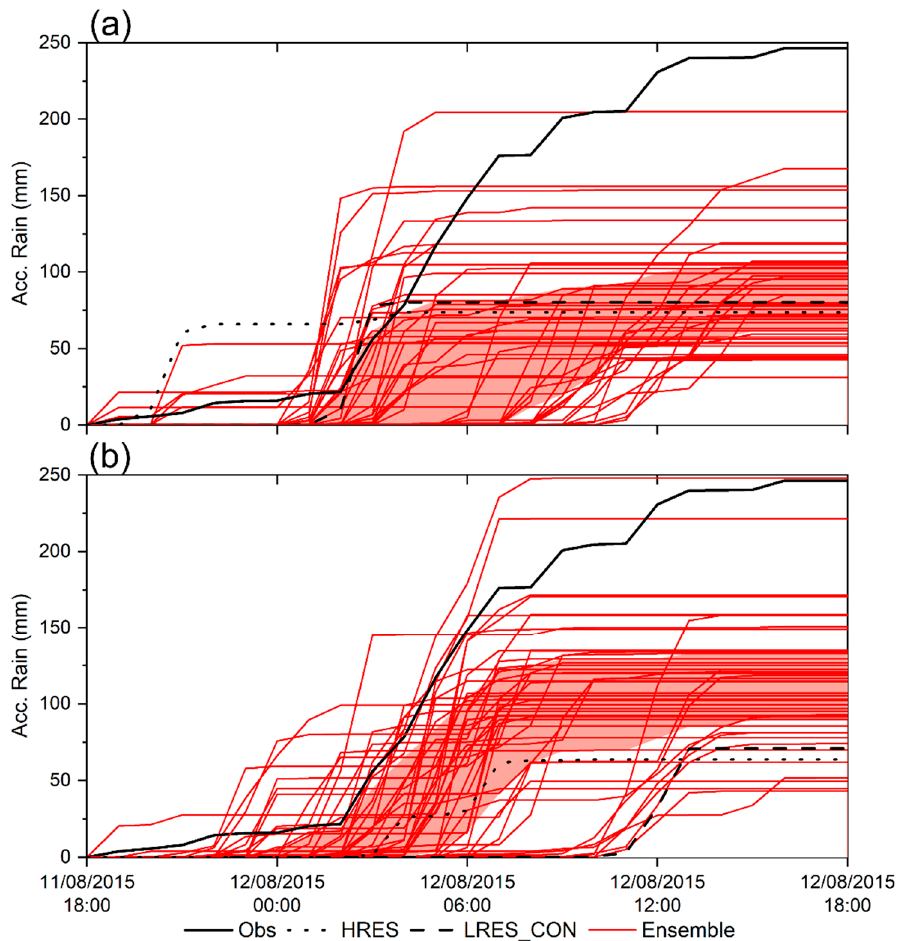
Figure 6. Spaghetti graphs of the accumulated rainfall peaks around the Corigliano rain gauge shown in Figure 5: ( a ) forecasts starting at 0000 UTC, 11 August 2015; ( b ) forecasts starting at 1200 UTC, 11 August 2015. The light red bands highlight the intervals between the 1st and the 3rd quartiles. The dotted line indicates the HRES simulation, while the dashed line is the low-resolution EPS control simulation.